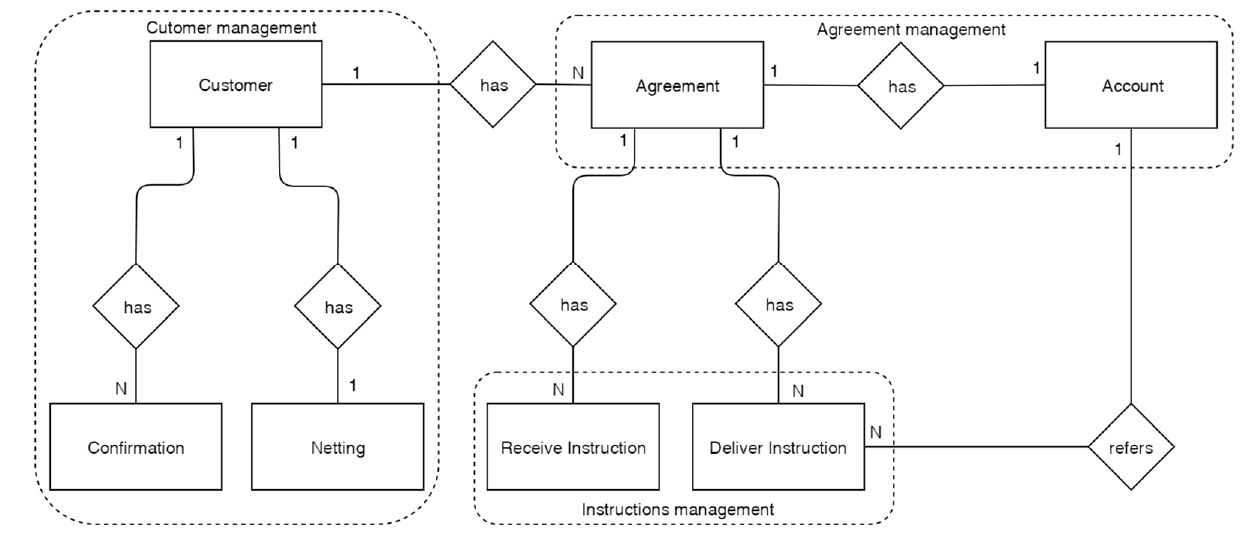
Figure 14. The segmentation units are identified in the simplified conceptual database schema.